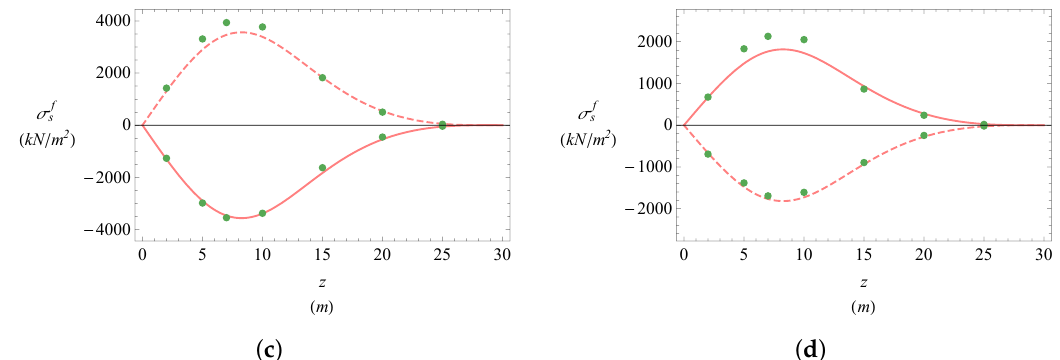
Figure 20. Torsion coupled to distortion: ( a , b ) Transverse normal stresses at bottom edges (continuous lines) and top edges (dashed lines): ( a , b ) stresses at z = 7.5m vs. s i , ( c , d ) stresses at the corners vs. z ; ( a , c ) element 1, ( b , d ) element 2. Fourier analysis with N = 50 terms, FEM analysis